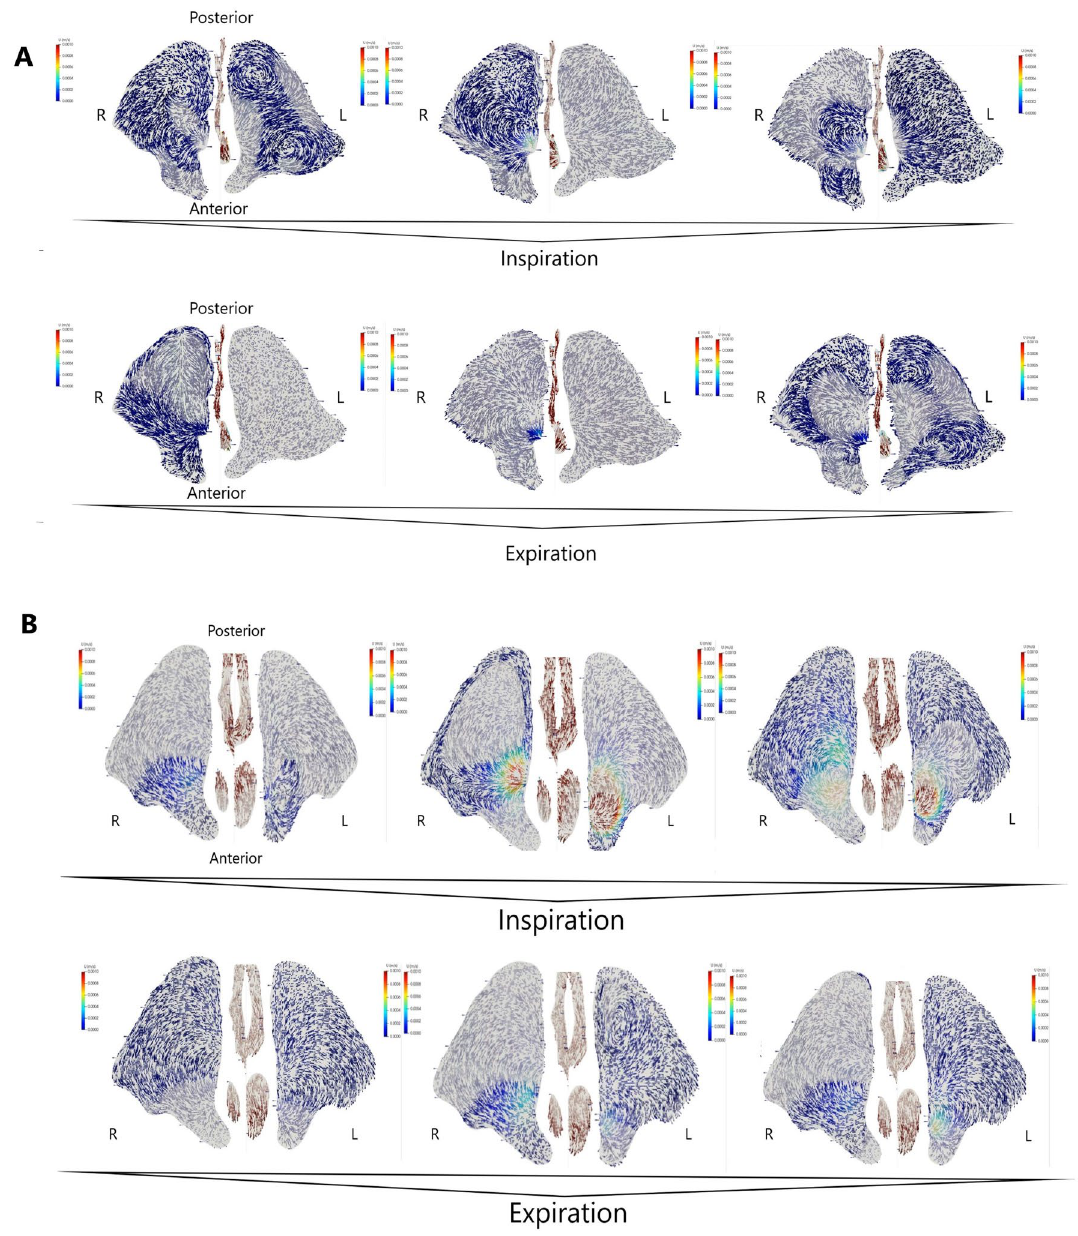
Figure 3. ( A ) Airflow in the maxillary sinus of Patient 1 (axial projection, middle part of maxillary sinus). Bilateral visualization of the maxillary sinus lumen, the nasal cavity excised in the middle of its height. Inspiration and expiration lasted 2 s each. Measurements were obtained at the start of each phase (first 0.2– 0.3 s), half-point (0.9–1.0 s), end (1.8–2.0 s); ( B ) Airflow in the maxillary sinus of Patient 2 (axial projection, middle part of maxillary sinus). Bilateral visualization of the maxillary sinus lumen, the nasal cavity excised in the middle of its height. Inspiration and expiration lasted 2 s each. Measurements were obtained at the start of each phase (first 0.2–0.3 s), half-point (0.9–1.0 s), end (1.8–2.0